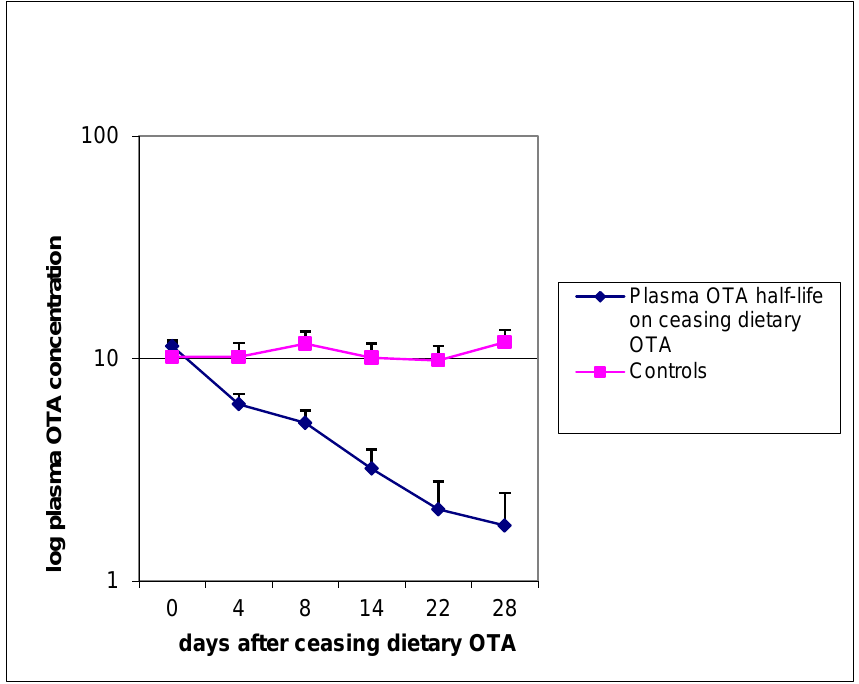
Figure 2. Comparative changes in plasma OTA concentration in groups of five rats during the month after either continuing or ceasing 10 months of daily exposure to 300 µg OTA/kg b.w. The slope of the ceasing group corresponds to a plasma half-life of 10